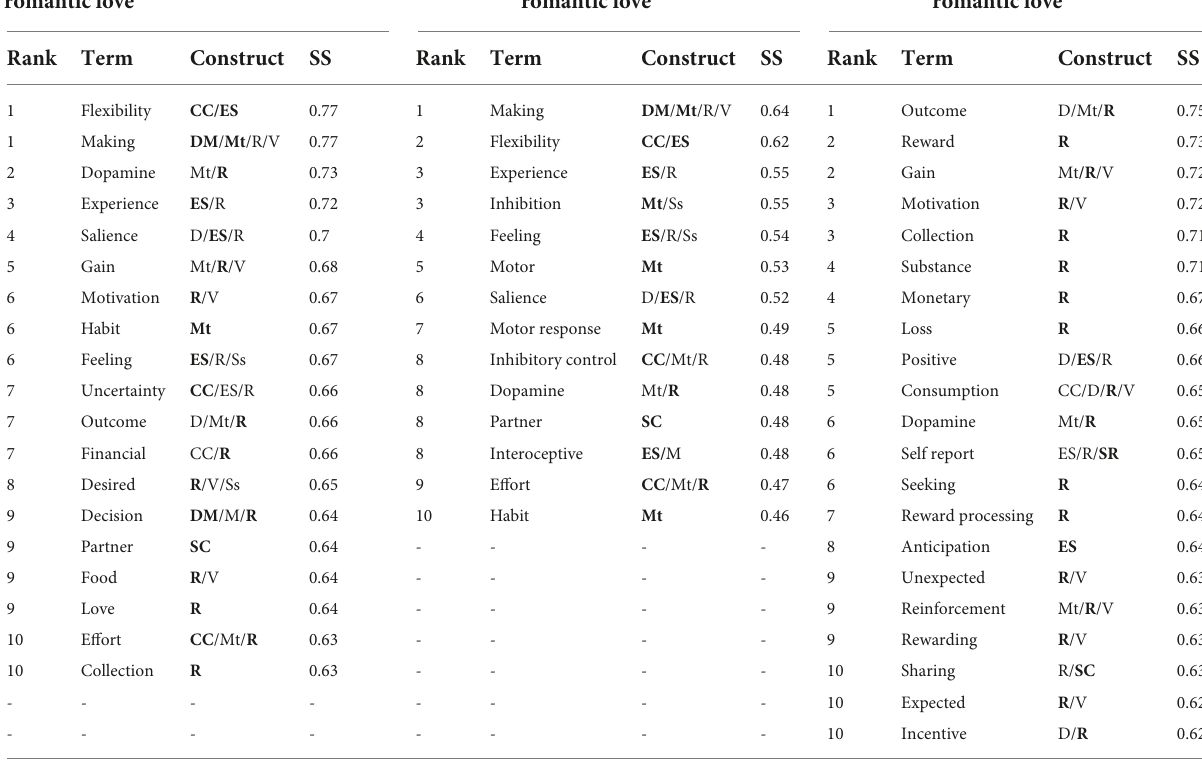
TABLE 3 Decoded results (stable-stage phase). Brand love and interpersonal romantic